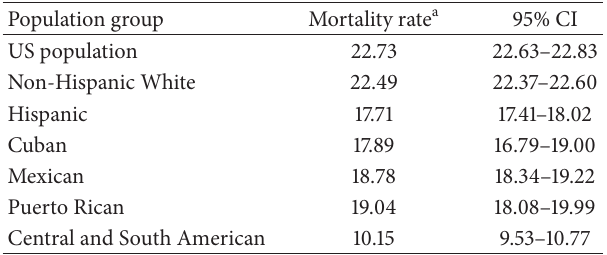
Source : National Center for Health Statistics. CI = confidence